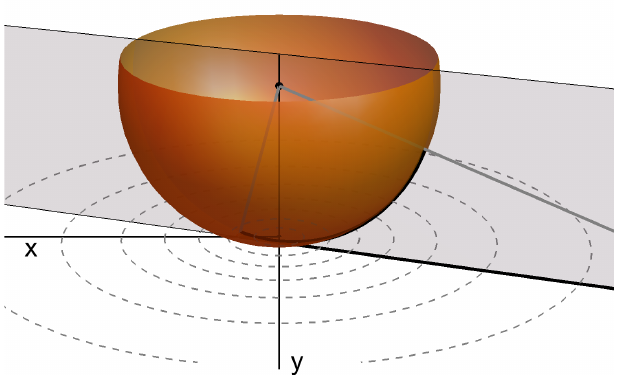
Figure 5. Geodesic arc of great circle on S 2 and explicit construction in 3D of its stereographic projection to the tangent polar plane E 2 , resulting in the straight segment connecting the red and blue points in Figure